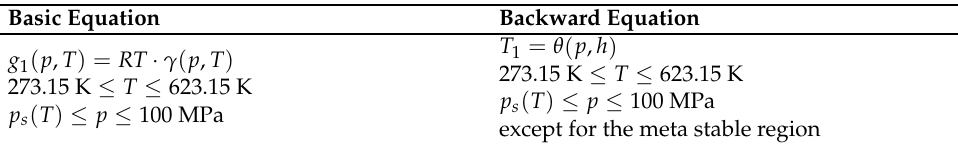
Table 2. Relations for region 1 in IAPWS-IF97.